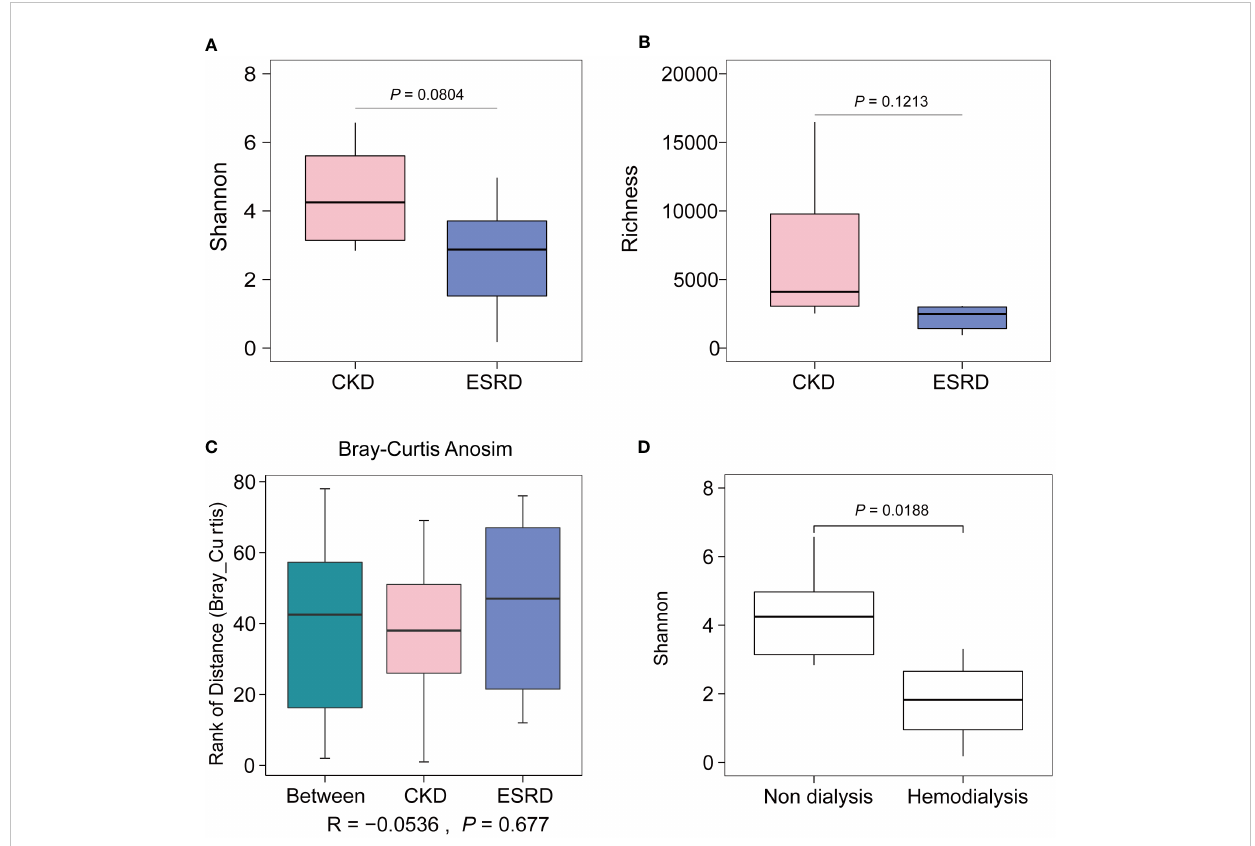
FIGURE 1 Alpha and beta diversity of CKD and ESRD group. (A) Shannon index, (B) Richness index shown the alpha diversity between two groups. (C) Comparison of signi fi cance of beta diversity between CKD and ESRD groups. (D) Comparison of Shannon Wiener according to whether hemodialysis or not. Data were analyzed by